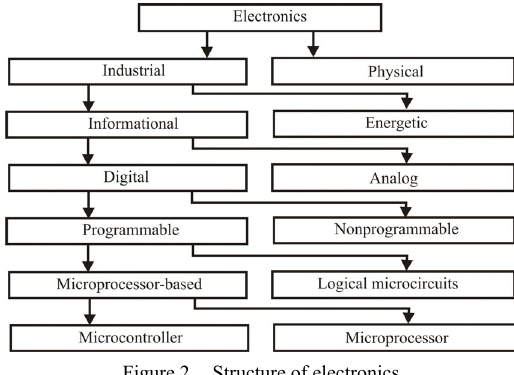
Figure 2. Structure of